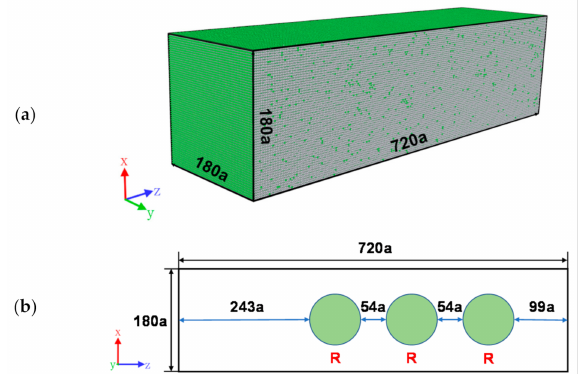
Figure 1. Molecular dynamics model with B2 phase as initial structure: ( a ) non-porous sample; ( b ) porous sample (R = 45